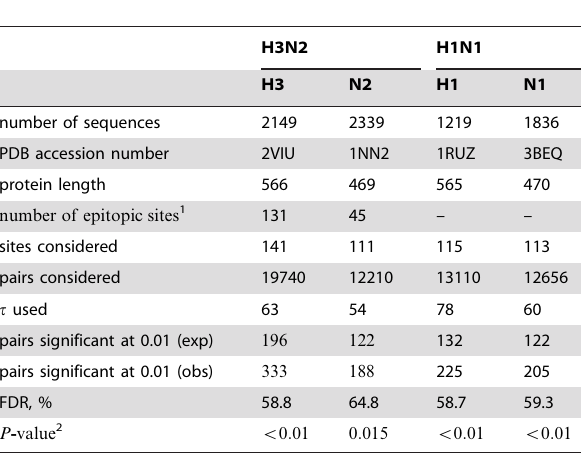
Table 1. Summary of data used in our analysis.